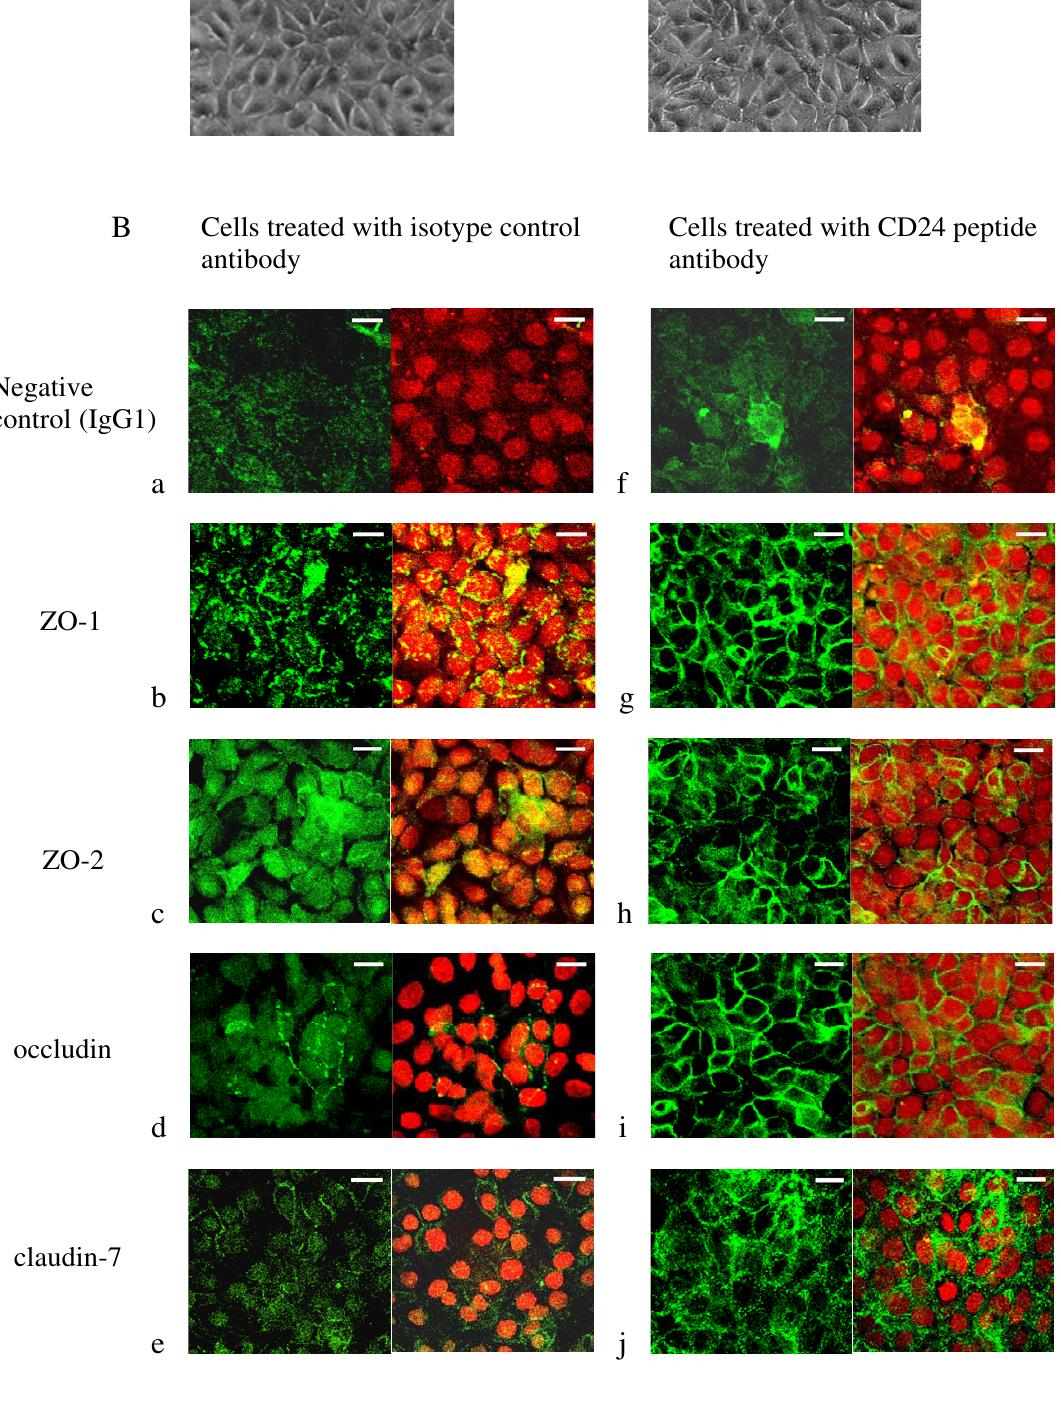
Figure 4 (see legend on next